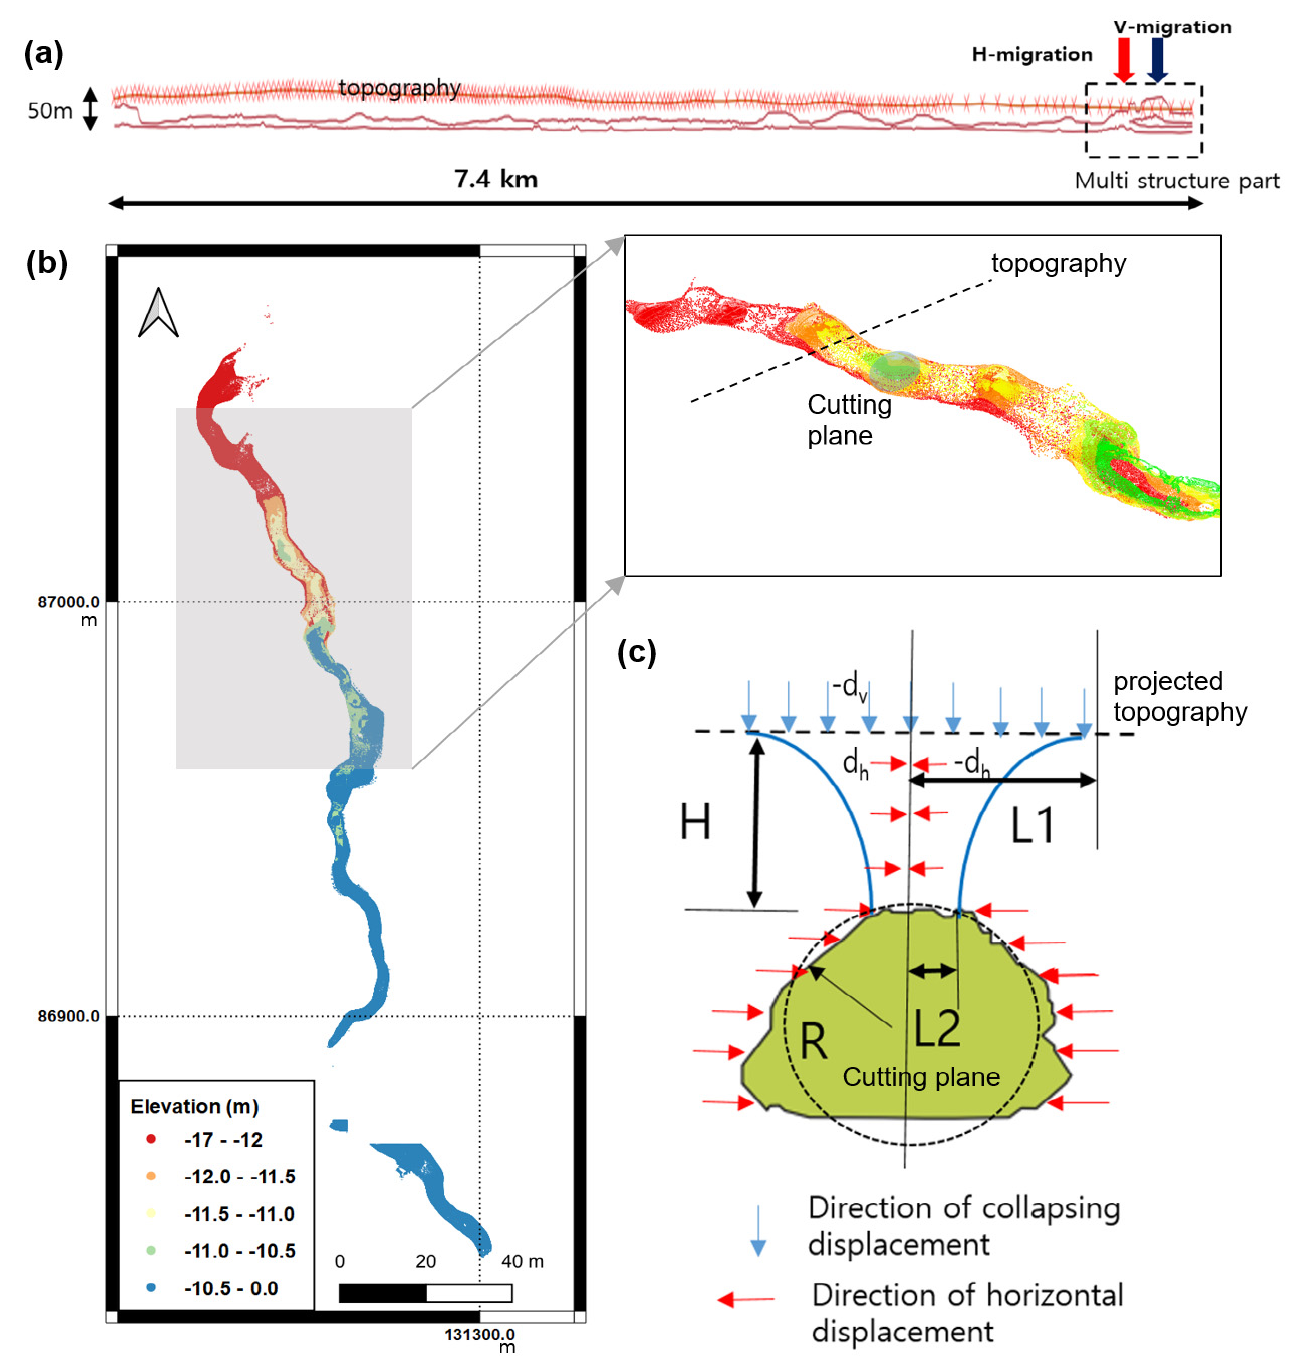
Figure 9. Examples of 2D/3D cave models and instability check. ( a ) The 2D profile of Manjang caves and the location of detected LTDPs on the terminus of the tube, which are digitized from [56]. ( b ) 3D LiDAR map in Gamnamdap cave with thin topography. ( c ) Diagram of expected deformations on cross-sectional lava tube (H: depth of cave, R: radius of approximated circular shape on lava tube, L1 and L2: the lengths of upper and lower parts of collapsing part, dh and dv: hypothesized H/V deformations at certain collapsing points). Refer to Figure 1 to identify cave locations. The map projection system of ( b ) is Korea 2000/Central Belt 2010.